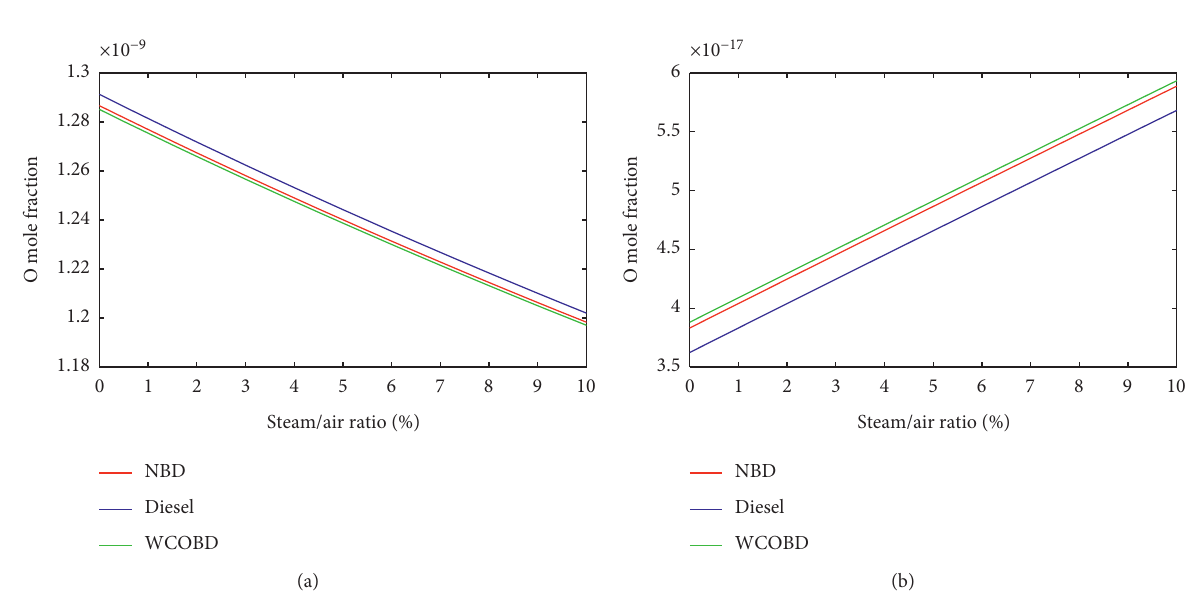
Figure 8: Variation of O equilibrium mole fractions with steam injection